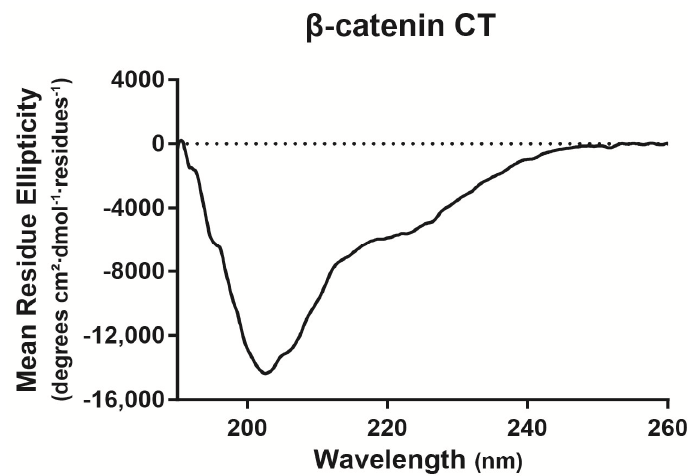
Figure 2. Circular dichroism spectrum showing the secondary structure of the β-catenin CT